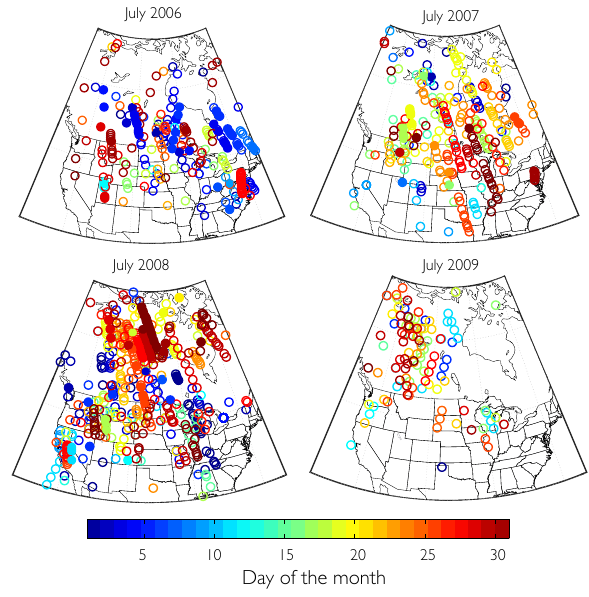
Figure 6. Successful TES PAN retrievals overlapping NOAA HMS smoke polygons for July 2006 to July 2009 colored by the day of the month. Filled circles denote the set of retrievals that also coincide with 510hPa CO greater than 150ppbv. This set of points is used to calculated PAN enhancement ratios relative to CO in Fig.